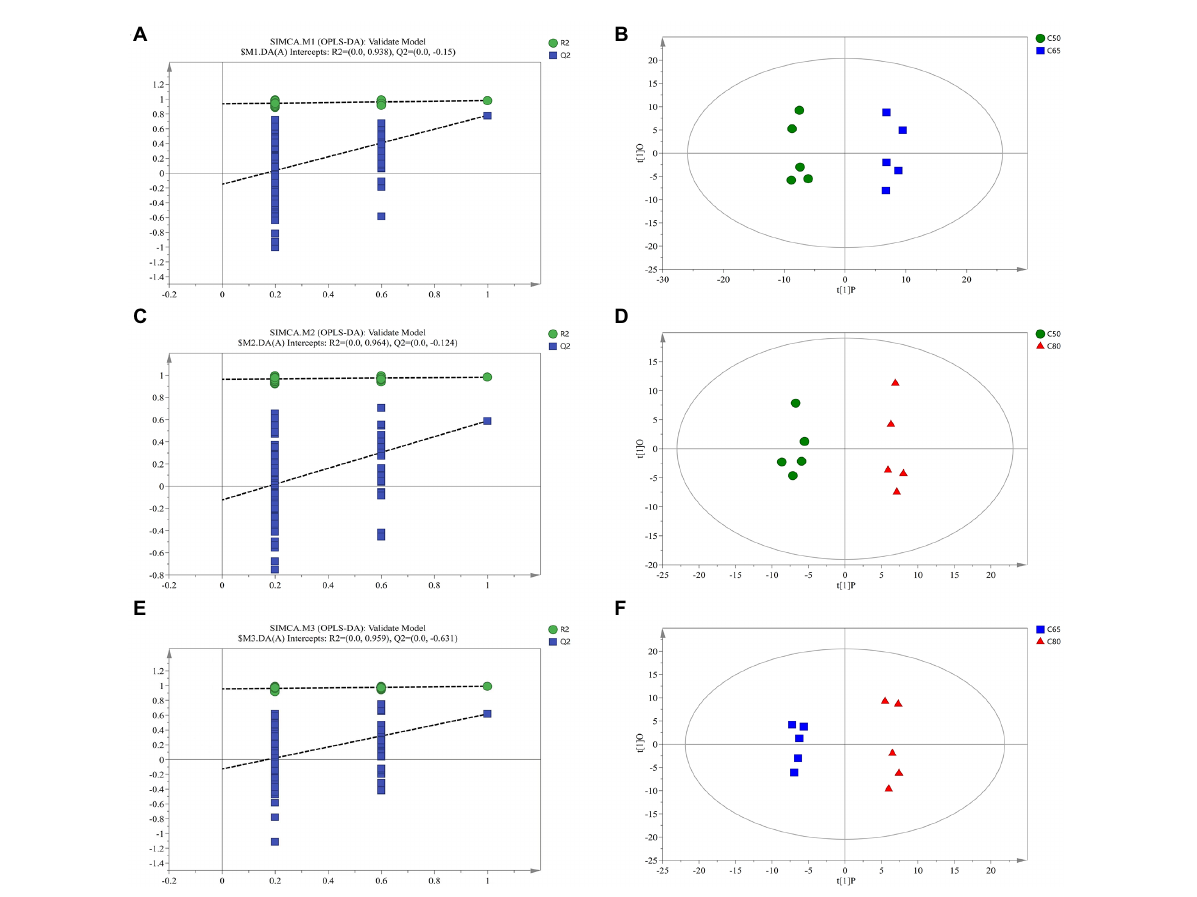
FIGURE 3 Corresponding validation plots and orthogonal projections to latent structures-discriminant analysis (OPLS-DA) score plots derived from gas chromatography time-of-flight mass spectrometer (GC-TOF/MS) metabolite profiles of yak rumen samples with different dietary concentrate ratios. Corresponding validation plots and OPLS-DA score plots for (A,B) group C50 vs. group C65 (C,D) group C50 vs. group C80, and (E,F) group C65 vs. group C80. C50, diets with 50% concentrate; C65, diets with 65% concentrate; C80, diets with 80%